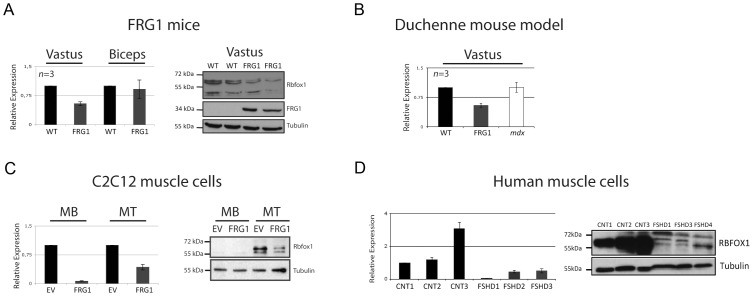

Rbfox1 is selectively down-regulated in mice, in cells over-expressing FRG1, and in FSHD patients.(a) Left panel: real-time RT-PCR analysis showing that in FRG1 mice Rbfox1 expression is preferentially downregulated in vastus lateralis compared to biceps brachii. Gapdh expression was used for sample normalization. Right panel: immunoblotting on vastus lateralis using anti-Rbfox1 antibody. Tubulin was used as loading control and FRG1 antibody as confirmation of the genotype. (b) Real-time RT-PCR analysis showing that Rbfox1 expression is normal in mdx mice. (c) Left: real-time RT-PCR analysis showing that Rbfox1 expression is down-regulated in proliferating (MB) or differentiating (MT) C2C12 muscle cells over-expressing FRG1. Right: immunoblotting using protein extracted from the same samples as in (c, left) using anti-Rbfox1 antibodies. Tubulin was used as loading control. Note that in proliferating C2C12 cells Rbfox1 protein is almost undetectable, while its levels significantly increase during myogenic differentiation. (d) Left panel: real-time RT-PCR analysis of RBFOX1 expression using RNA extracted from muscle cells derived from three different normal individuals and three different FSHD patients. Right panel: immunoblotting using protein extracted from the same samples as in (d, left) using anti-RBFOX1 antibody. Tubulin was used as loading control.